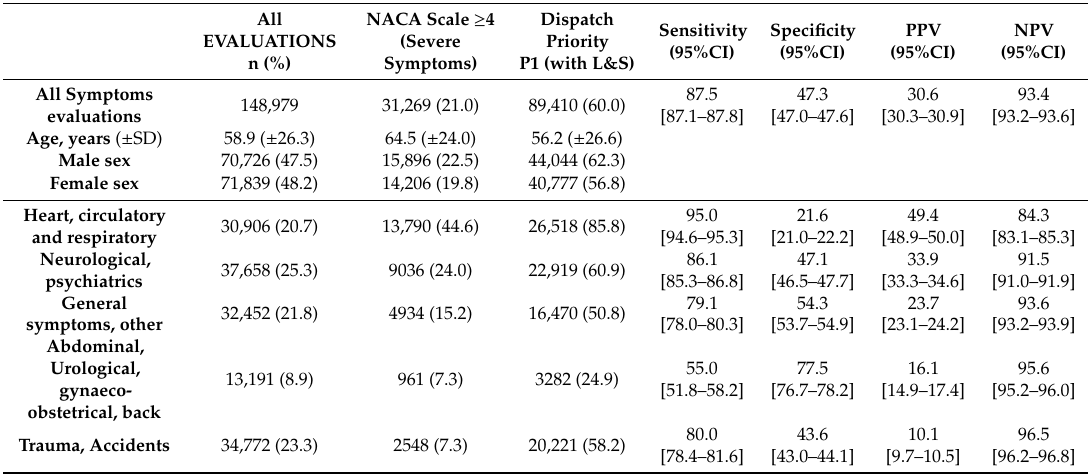
Table 1. Priorities for dispatching ambulances with L&S compared to NACA situations ≥ 4 found in the field, by symptom categories.